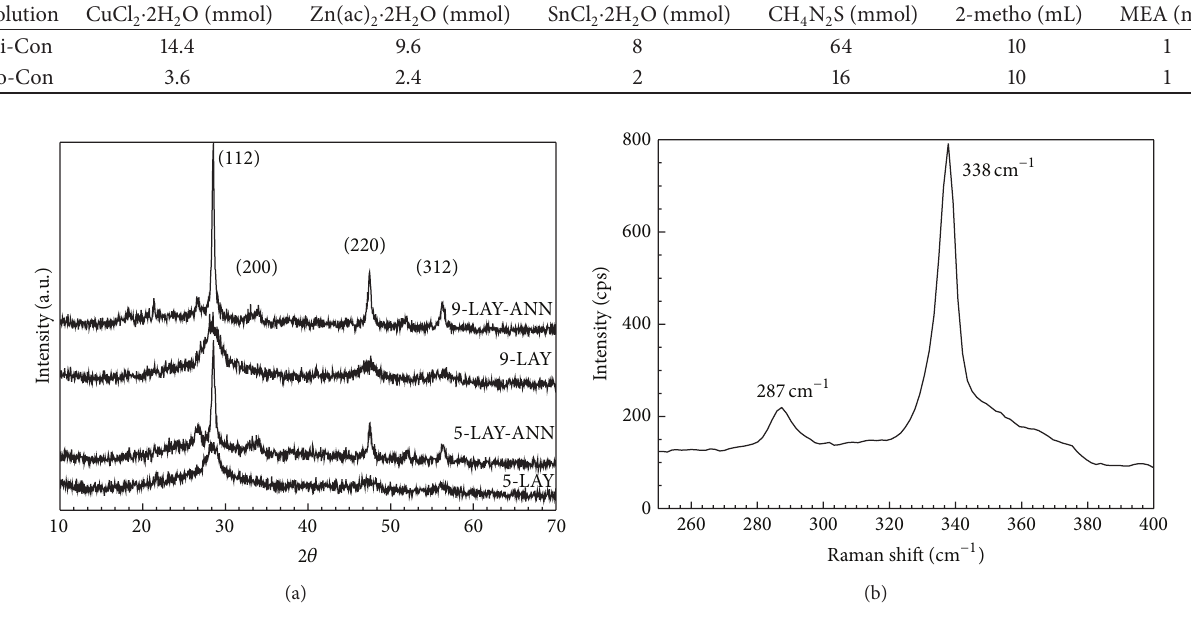
Table 1: The amount of starting materials in the two solutions.